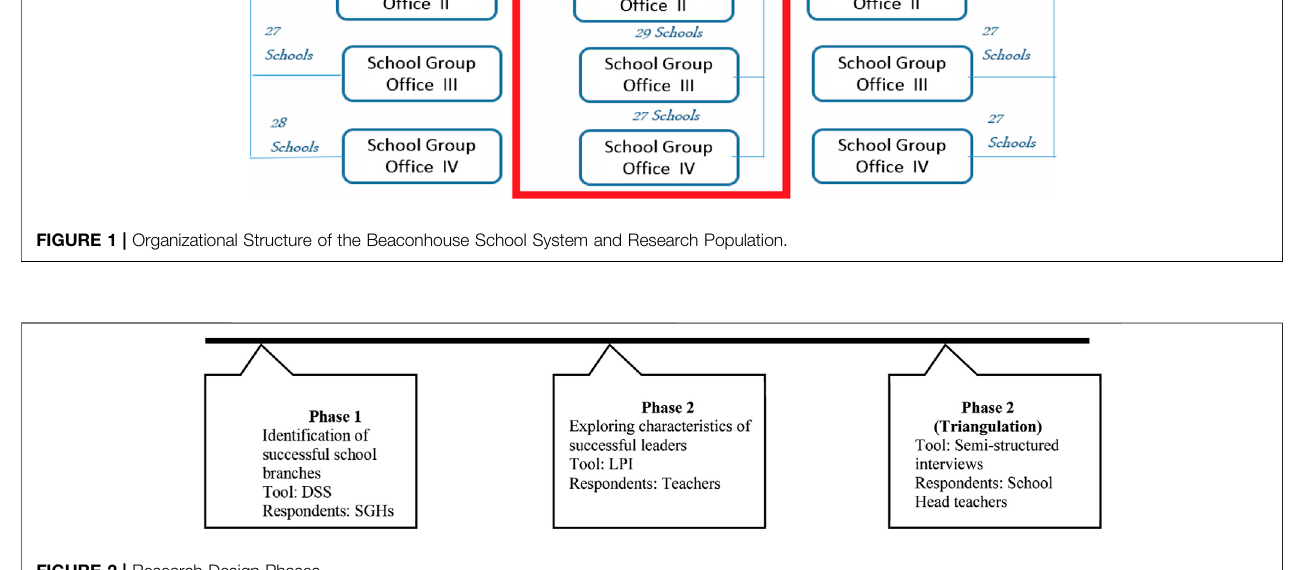
FIGURE 2 | Research Design